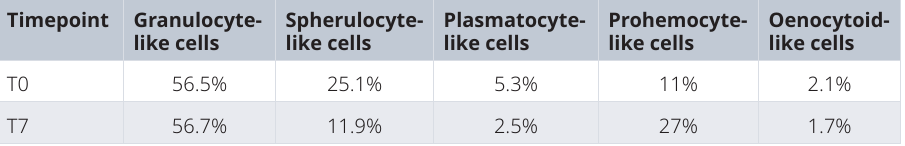
Table 3. Percentages of different hemocyte cell types at T0 or T7, isolated from sham injected larvae. Differential hemocyte counts were based on morphological differences of unstained cells under 20 × magnification. Percentages shown are the averages across five views per well from triplicate wells of hemolymph pooled from 10